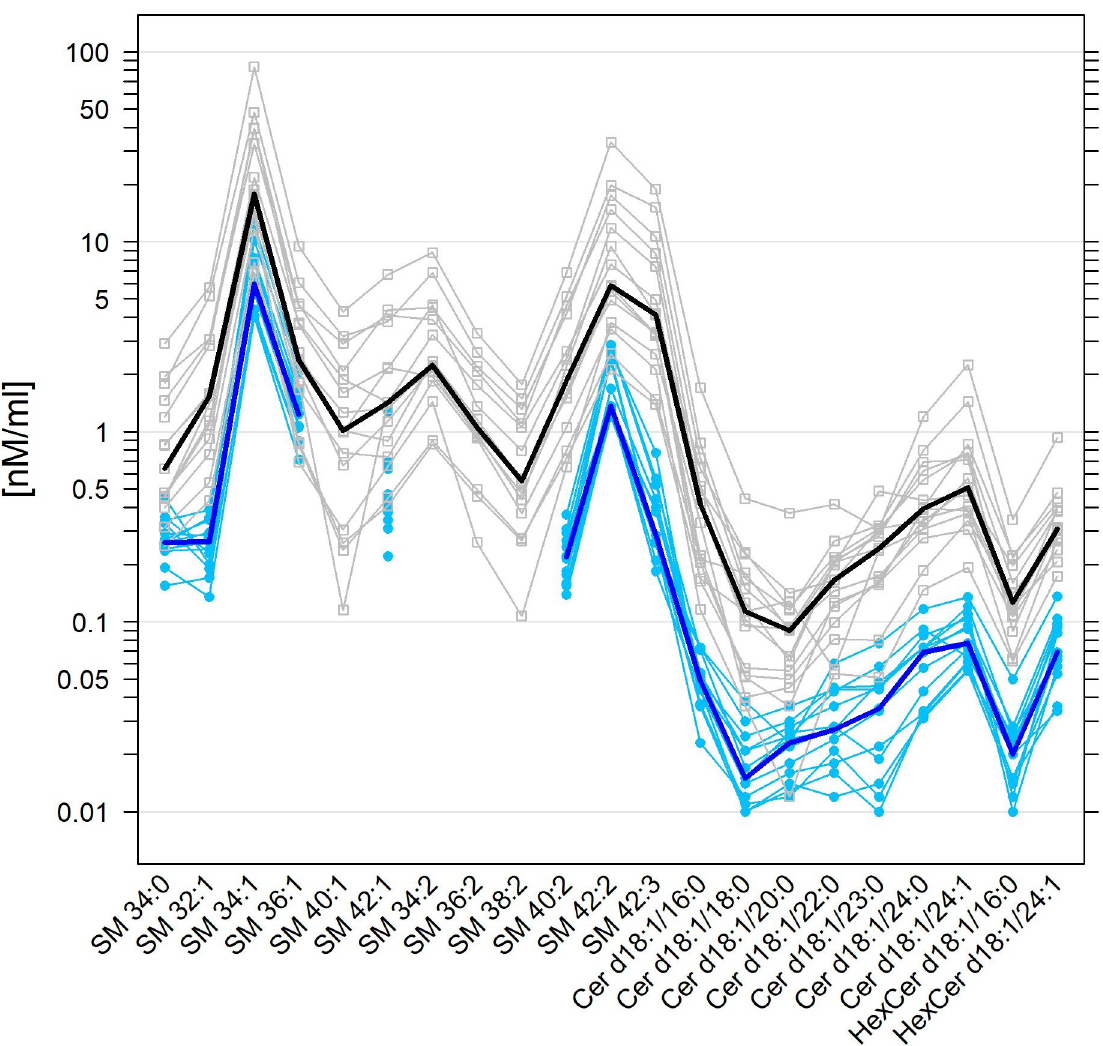
Fig 4. Superposed parallel plots for normal human and equine SF levels of SM and Cer species. For further details, see the caption of Fig 2, which is fully analogous, but here for SM and Cer